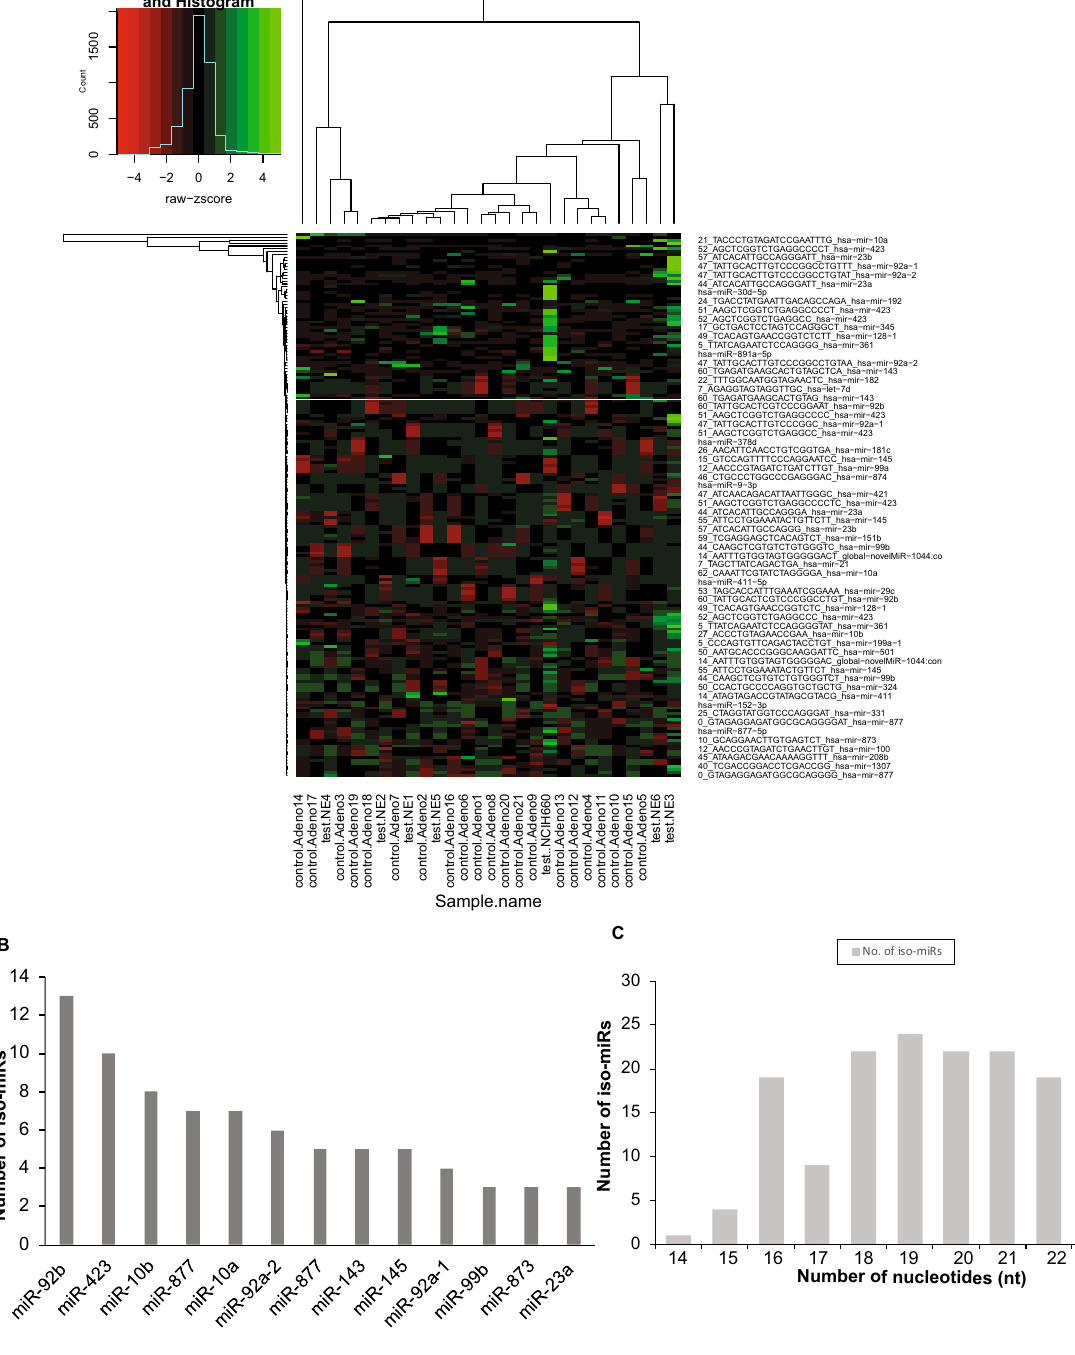
patients (Fig. 5) (n = 4) and primary prostate adenocarcinomas (n = 4). Following characterization of EVs by NTA and Western blotting for exosomal markers (Fig. 5B), EV-miRNAs were extracted followed by small RNA